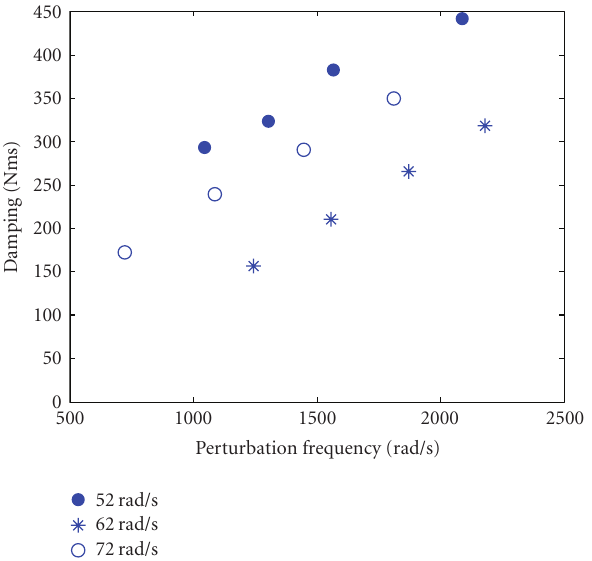
Figure 6: Additional damping as a function of perturbing fre- quency and operating condition.